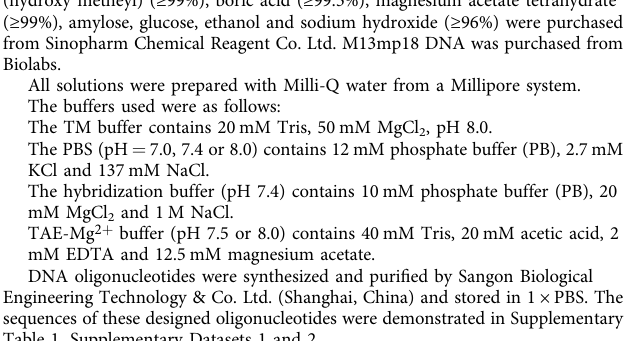
Table 1, Supplementary Datasets 1 and 2. Protein-TDN conjugation . The protein and DNA were linked by SPDP 39 . The SOX and HRP were quanti fi ed with a Hitachi U-3010 UV − vis spectrophotometer (Japan). SOX was linked with linker 1 (L 1 ), HRP was linked with linker 2 (L 2 ), while amyloglucosidase was conjugated with Linker 3 (L 3 ). DNA strands in Sup- plementary Table 1 were dissolved in H 2 O, yielding a fi nal concentration of 50 μ M. To fabricate TDNs, a quantity of 1 μ L of each DNA strand as in Supplementary